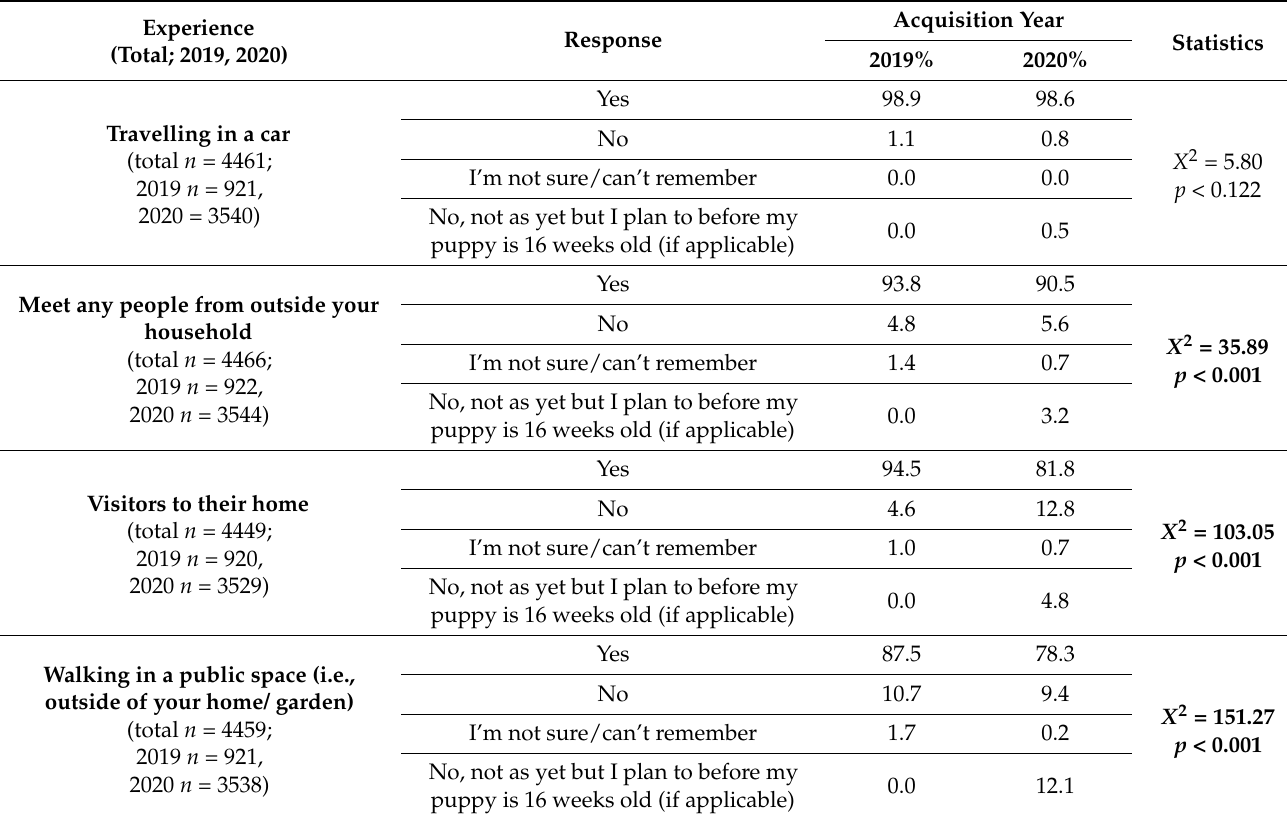
Table 9. Comparison of owner-reported socialisation experiences under the age of 16 weeks of 2019 puppies and Pandemic Puppies in response to the question “Did your puppy/dog encounter any of the following experiences between you buying them and reaching 16 weeks of age”. Sample size var- ied for each experience and are therefore shown in brackets. The response options listed represent all the choices available to respondents. Significant differences between the two cohorts are